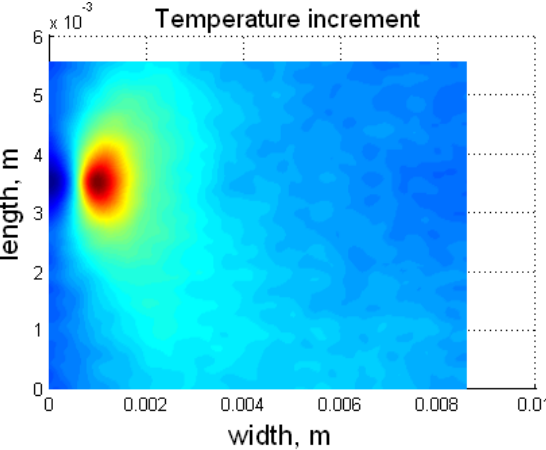
Figure 4: The temperature field after all stages of signal